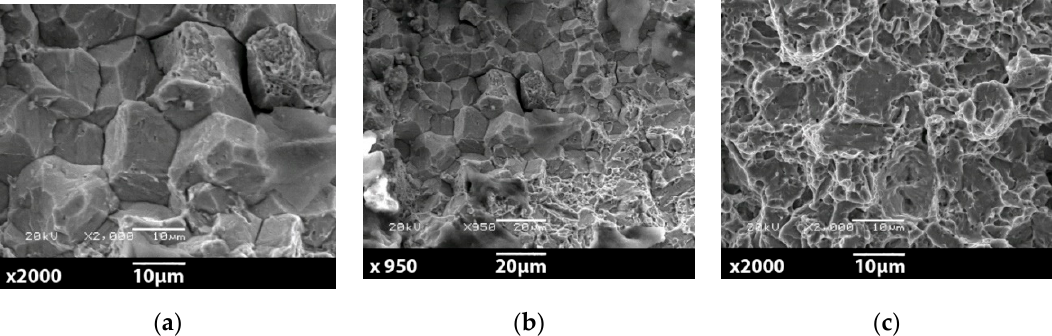
Figure 32. Fracture of 41Cr4 + Q—54 HRC: ( a ) on the notch-edge; ( b ) transition between two types of crack; and ( c ) central area of sample.